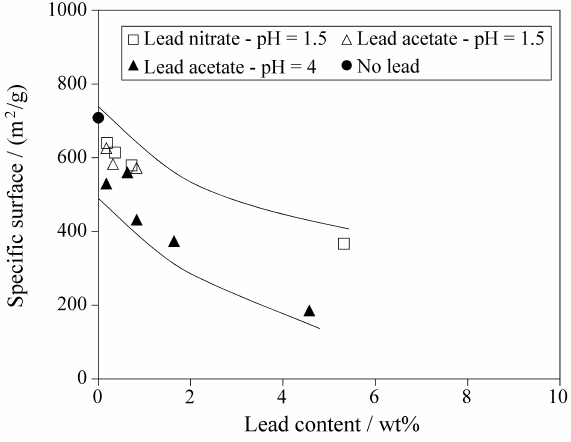
Figure 2. Specific surface area as a function of lead content.